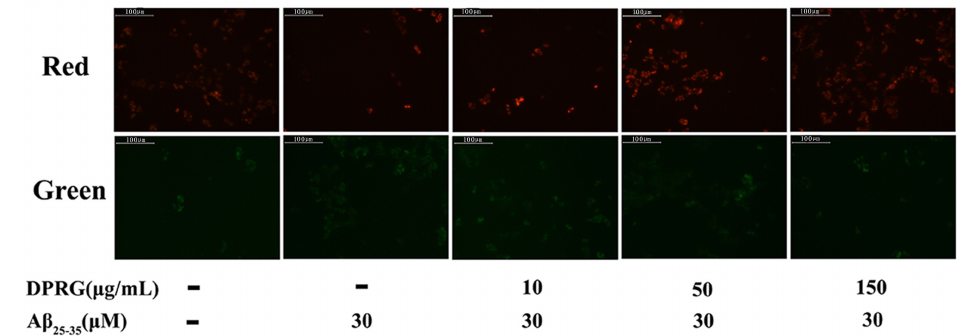
Figure 6. Effect of DPRG on Aβ 25-35 -treated PC12 cells by JC-1 staining. The figures from left to right